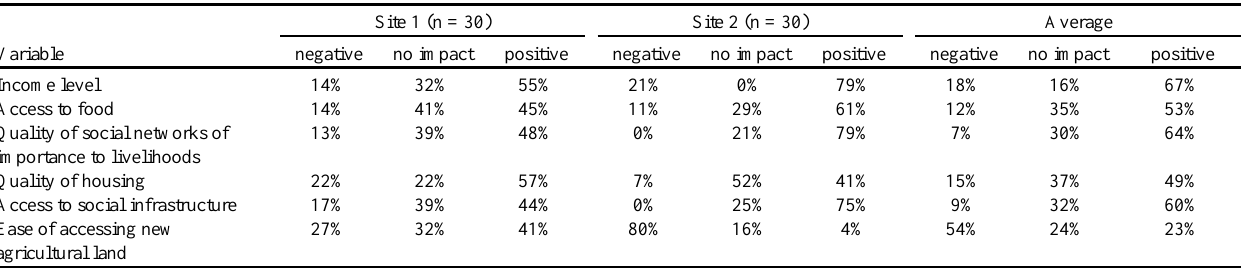
Table 12 . Attributes to livelihood impact for investing households group.